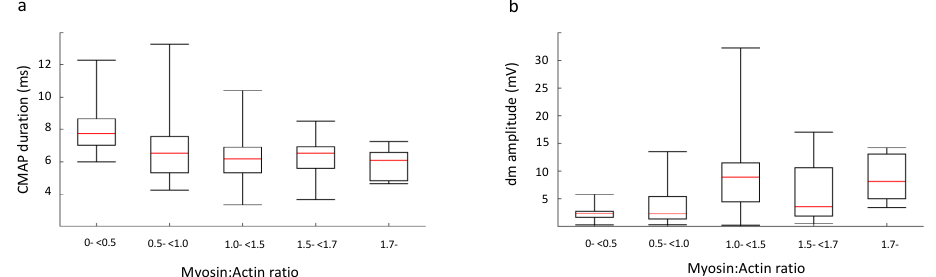
Figure 7. The patients were classified into five groups depending on M:A ratio, as described in Methods. We examined the difference between the five groups in relation to a) compound muscle action potential (CMAP) duration, measured using nerve stimulation and surface muscle electrodes, and b) CMAP amplitude measured intramuscularly. The differences were compared with a one-way ANOVA and significant differences ( p < 0.01) were found for CMAP amplitude elicited using direct muscle stimulation. Individual analysis between the five groups revealed a significant difference between m-<0.5 and 1.0-<1.7 of p < 0.05 and between m-<0.5 and <1.7 of p < 0.01.